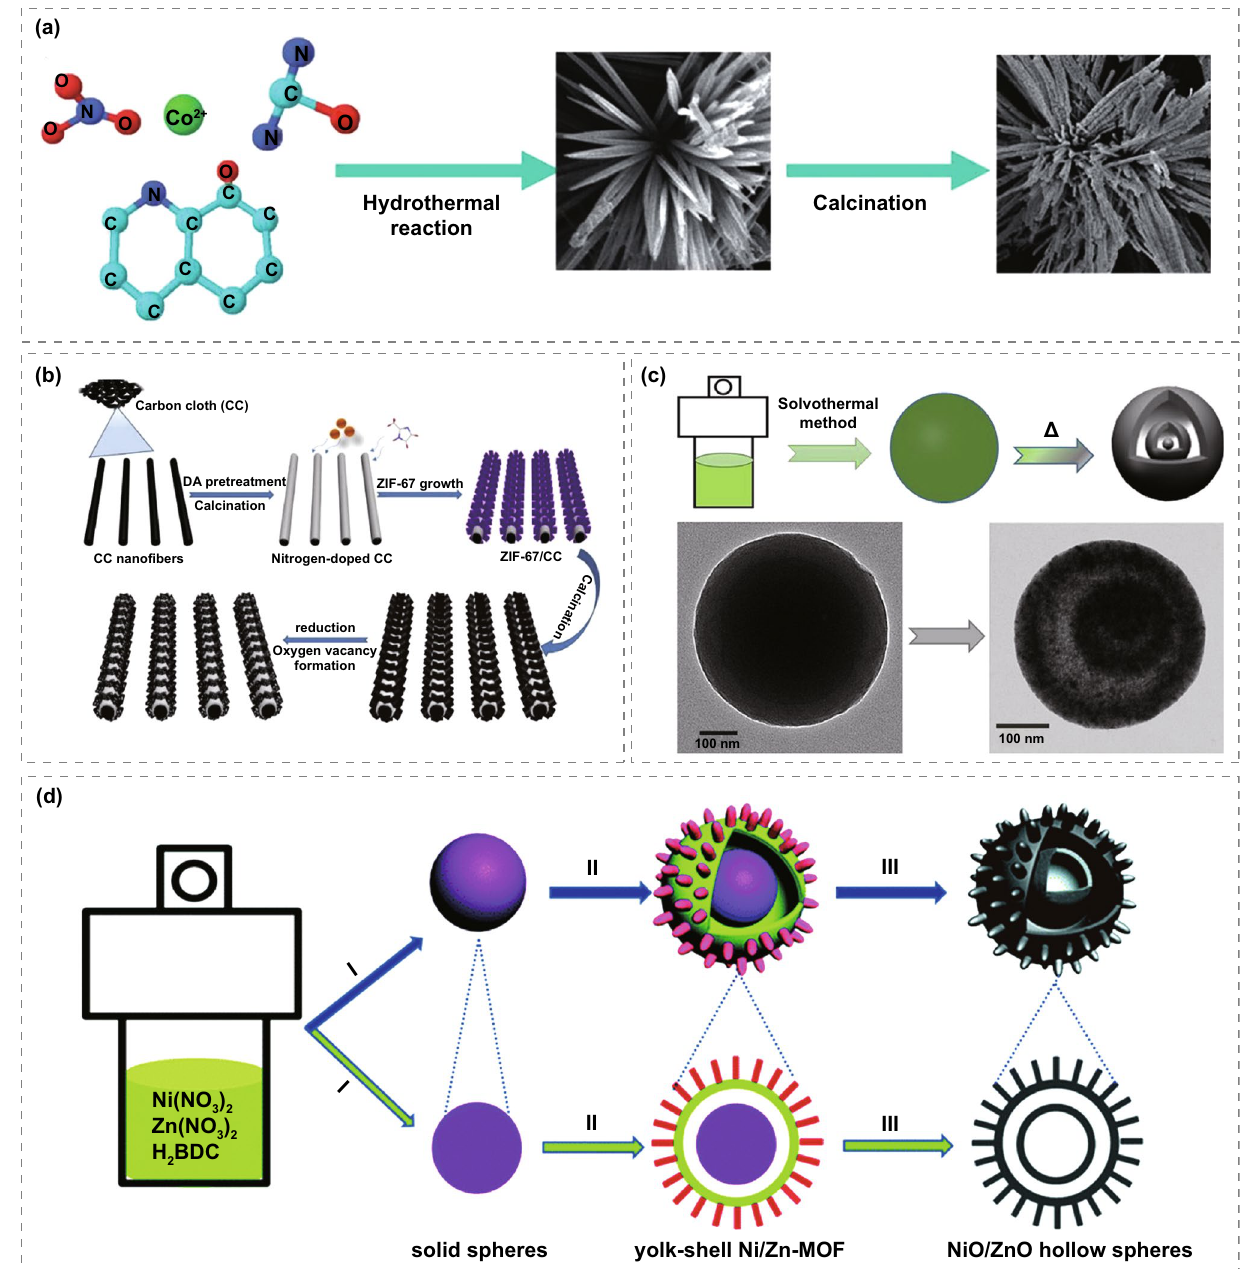
Fig. 11 a Synthesis scheme of Co 3 O 4 nanostructure. Reprinted with permission from Ref. [143]. Copyright 2012 Royal Society of Chemistry. b Nitrogen-doped Co 3 O 4 nanosheets contain oxygen vacancy prepared on CC substrate. Reprinted with permission from Ref. [145]. Copyright 2019 Elsevier Ltd. c Diagram of synthesis of NiO nanospheres. Reprinted with permission from Ref. [147]. Copyright 2017 Elsevier B.V. d Schematic diagram of synthesis for NiO/ZnO hollow spheres with double shells. Reprinted with permission from Ref. [148]. Copyright 2016 Royal Society of